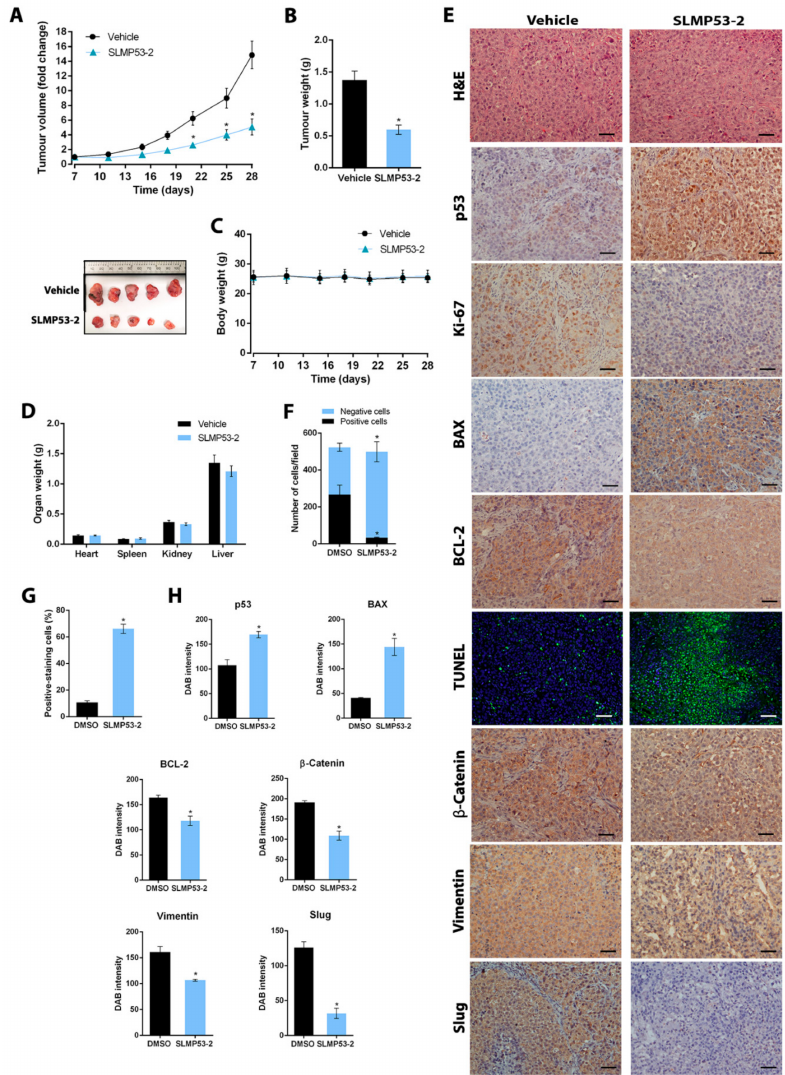
Figure 8. In vivo melanoma antitumour activity of SLMP53-2. C57BL/6-Rag2 − / − IL2rg − / − mice carrying A375 xenografts were treated with 50 mg · kg − 1 SLMP53-2 or vehicle by intraperitoneal injection twice a week for a total of six administrations. ( A ) Tumour volume curves of mice carrying A375 xenografts treated with SLMP53-2 or vehicle. Fold change is relative to the start of treatments; data are mean ± SEM, n = 7; values are significantly different from vehicle: * p < 0.05, two-way ANOVA followed by Sidak’s test. ( B ) Tumour weights measured at the end of the in vivo experiment; data are mean ± SEM, n = 7; values are significantly different from vehicle: * p < 0.05, unpaired Student’s t -test. Representative images of the tumours treated with SLMP53-2 or vehicle at the end of the experiment. ( C ) Body weight of the mice registered during the course of the experiment. Data are mean ± SEM, n = 7; values are not significantly different from vehicle: p > 0.05, two-way ANOVA followed by Sidak’s test. ( D ) Weight of heart, spleen, kidney and livers from animals treated with SLMP53-2 or vehicle. Data are mean ± SEM, n = 7; values are not significantly different from vehicle: p > 0.05, two-way ANOVA followed by Sidak’s test. ( E ) Representative images of p53, Ki-67, BAX, BCL-2, TUNEL, β -catenin, Vimentin, and Slug detection in tumour tissues of A375 xenografts treated with SLMP53-2 or vehicle, collected at the end of treatment (scale bar = 5 µ m; magnificatio n = 200 × ); haematoxylin and eosin (H&E). ( F – H ) Quantification of immunohistochemistry of A375 xenograft tumour tissues treated with SLMP53-2 or vehicle. In F, quantification of the number of Ki-67-positive and -negative cells; values are significantly different from vehicle: * p < 0.05, two-way ANOVA followed by Sidak’s test. In G, quantification of the percentage of positive-staining cells with TUNEL, n = 5; values are significantly different from vehicle: * p < 0.05, unpaired Student’s t -test. In H, quantification of the p53, Vimentin, BAX, BCL-2, β -catenin and Slug staining by evaluation of 3,3 (cid:48) -diaminobenzidine (DAB) intensity is shown, n = 5; values are significantly different from vehicle: * p < 0.05, unpaired Student’s t